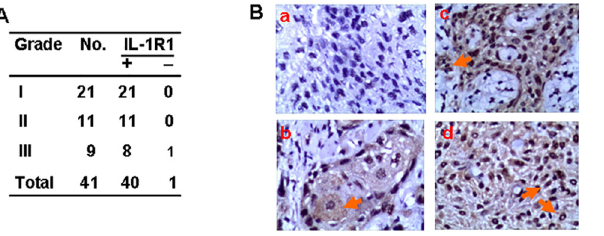
procedures. Specimens were sectioned, stained with anti-human IL-1R1 antibody, and counterstained with hematoxylin. (B) Representative negative staining in poorly differentiated TSCC (Ba), and representative positive staining in well (Bb), moderately (Bc), and poorly (Bd) differentiated TSCC. The arrow in Figure Bb indicates the positive cytoplasmic staining. The arrow in Figure Bc indicates the positive nuclear staining in stromal cells. The arrows in Figure Bd indicate positive nuclear and peri-nuclear